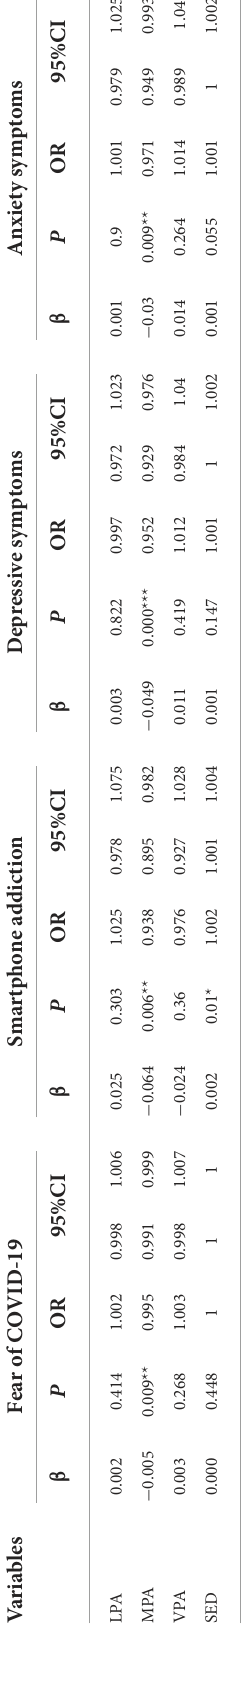
TABLE 1 Participants’